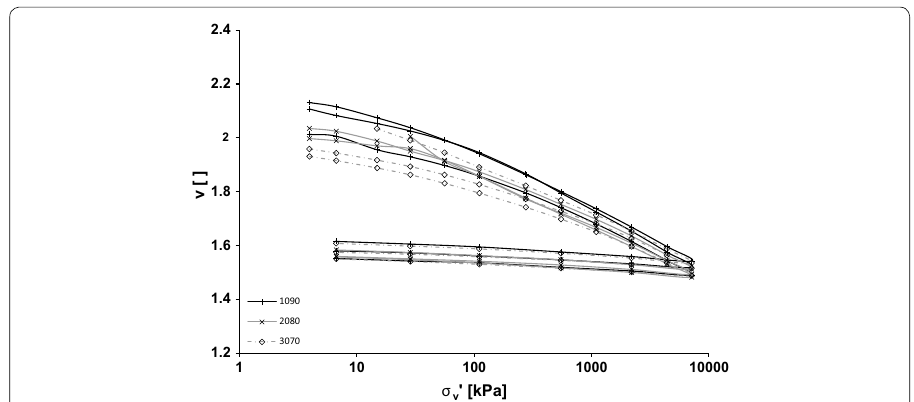
Fig. 5 One-dimensional compression data for the HDV mixtures